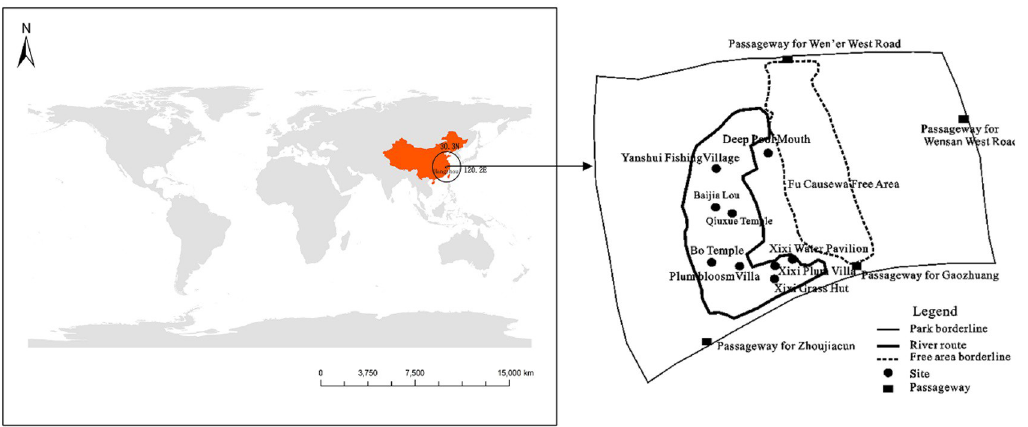
Fig 2. Geographical location of Xixi National Wetland